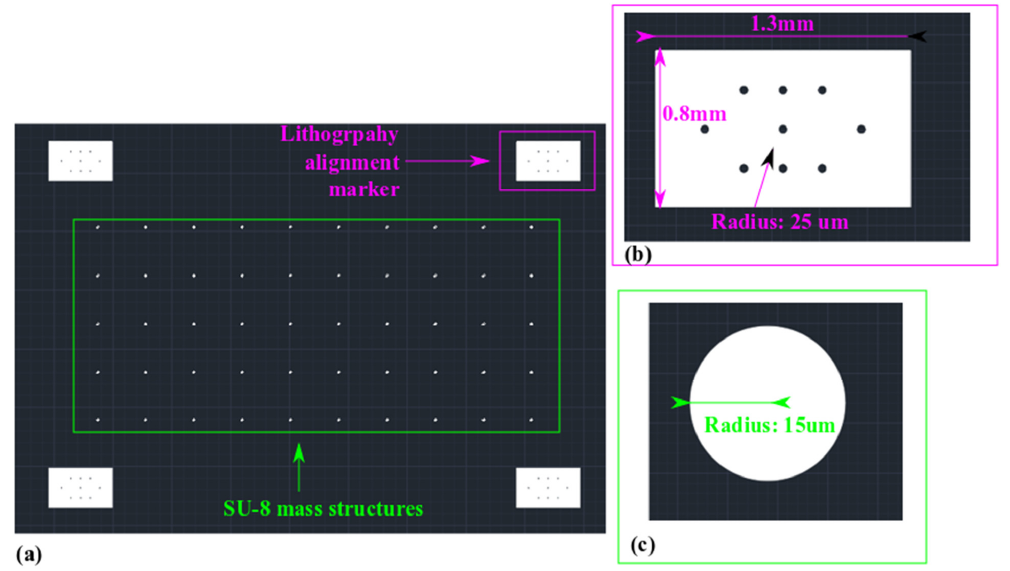
Figure 10. Lithography mask for SU-8 mass load. ( a ) Overall view. ( b ) Zoom-in view of the alignment markers. ( c ) Zoom-in view of a single mass load. SU-8 photoresist is a crosslinking-based negative photoresist epoxy. The polymeri-